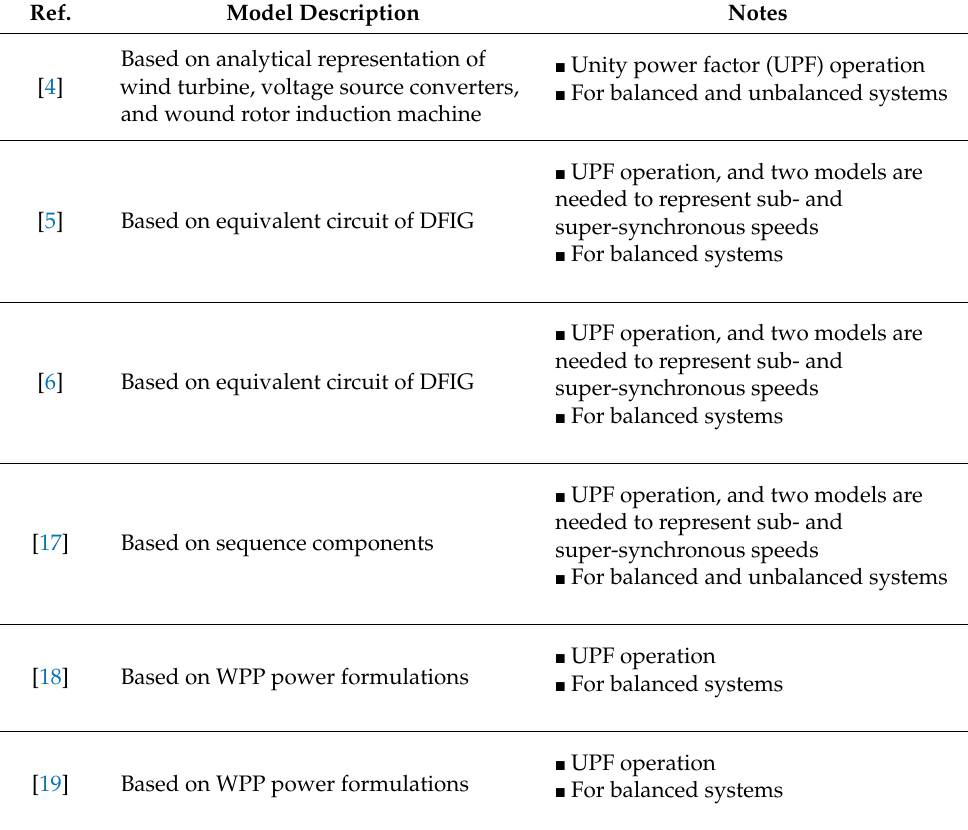
Table 1. Previously published models of DFIG-based WPP.